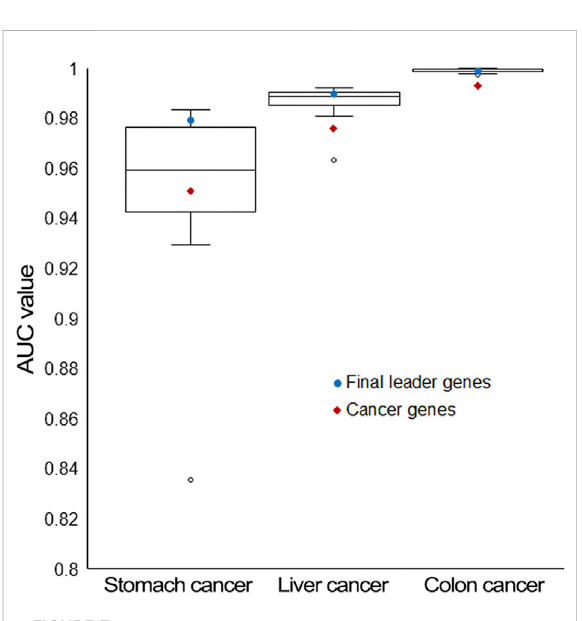
FIGURE 7 Classi fi cation performance comparison for three types of genes. Final leader genes are represented by blue dots, randomly selected fi nal leader genes (the same number as cancer genes)are represented by box plots, and cancer genes are represented by red